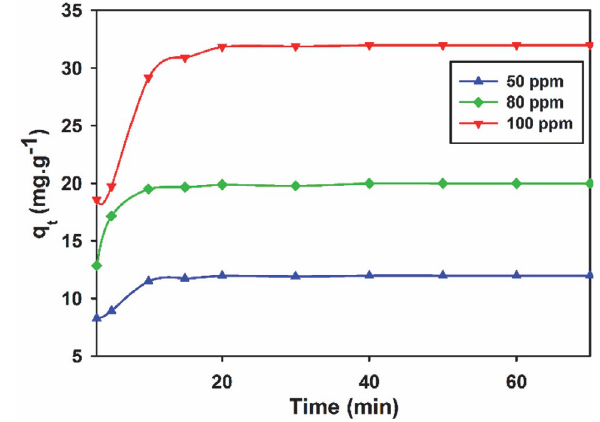
Figure 11. Isothermal adsorption modeling results.